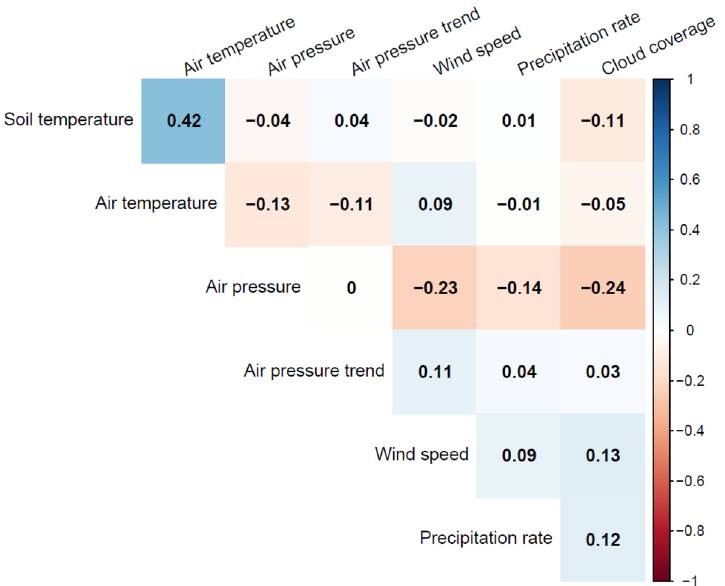
Figure 6. Correlation matrix between environmental predictor variables.